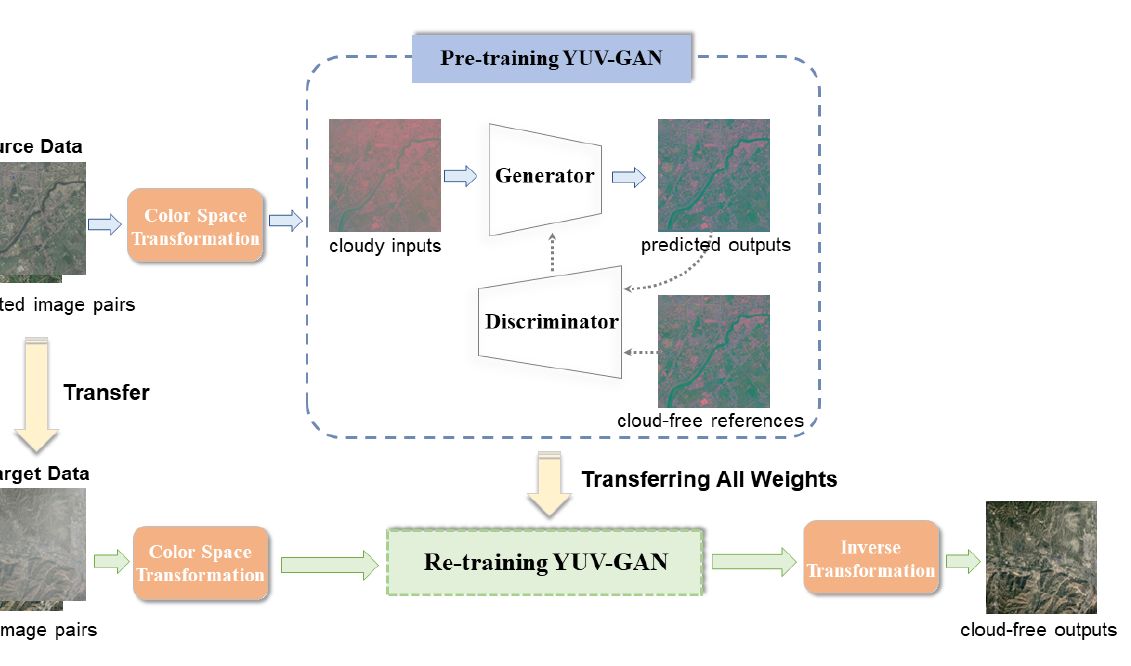
Figure 1. Overall framework of our